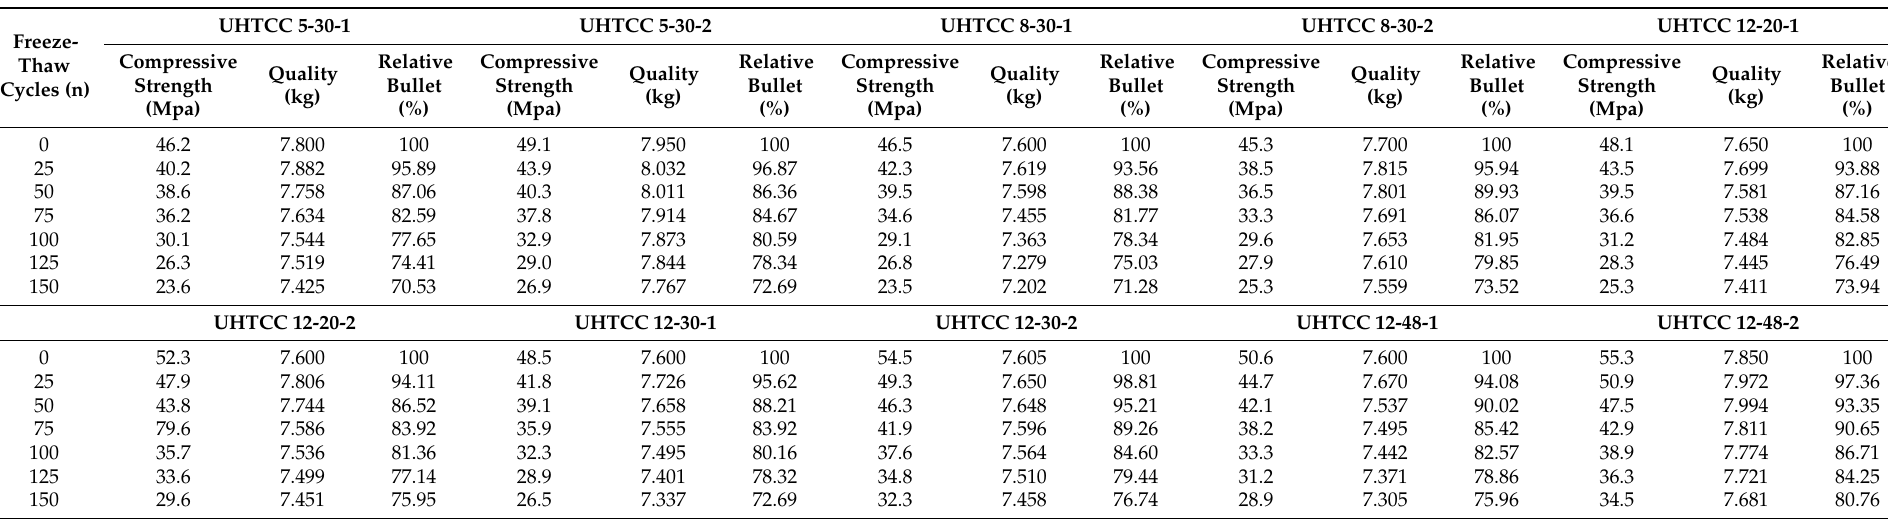
Table 3. UHTCC freeze–thaw cycle test